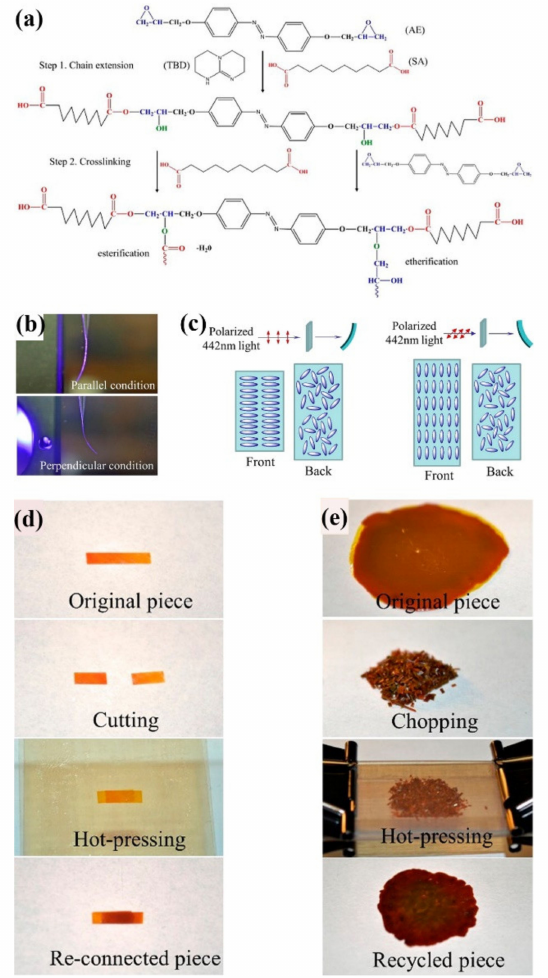
Figure 12. ( a ) Synthesis route and reaction mechanism of multifunctional LCNs. ( b , c ) Photome- chanical behavior of LCNs: ( b ) blue light-induced deformation of LCN film (10 mm × 1 mm × 15 µ m) at a light intensity of 40 mW/cm 2 ; top: light polarization direction parallel to the long axis of the LCN film; bottom: light polarization direction perpendicular to the long axis of the LCN film; ( c ) mechanism of bidirectional bending behaviors of the LCNs under blue light irradiation. ( d , e ) Reprocessability of the LCNs: ( d ) reconnecting broken pieces using a transesterification reac- tion; ( e ) reprocessing LCN pieces by hot pressing. Reprinted with permission from Reference [68]. Copyright 2016 American Chemical